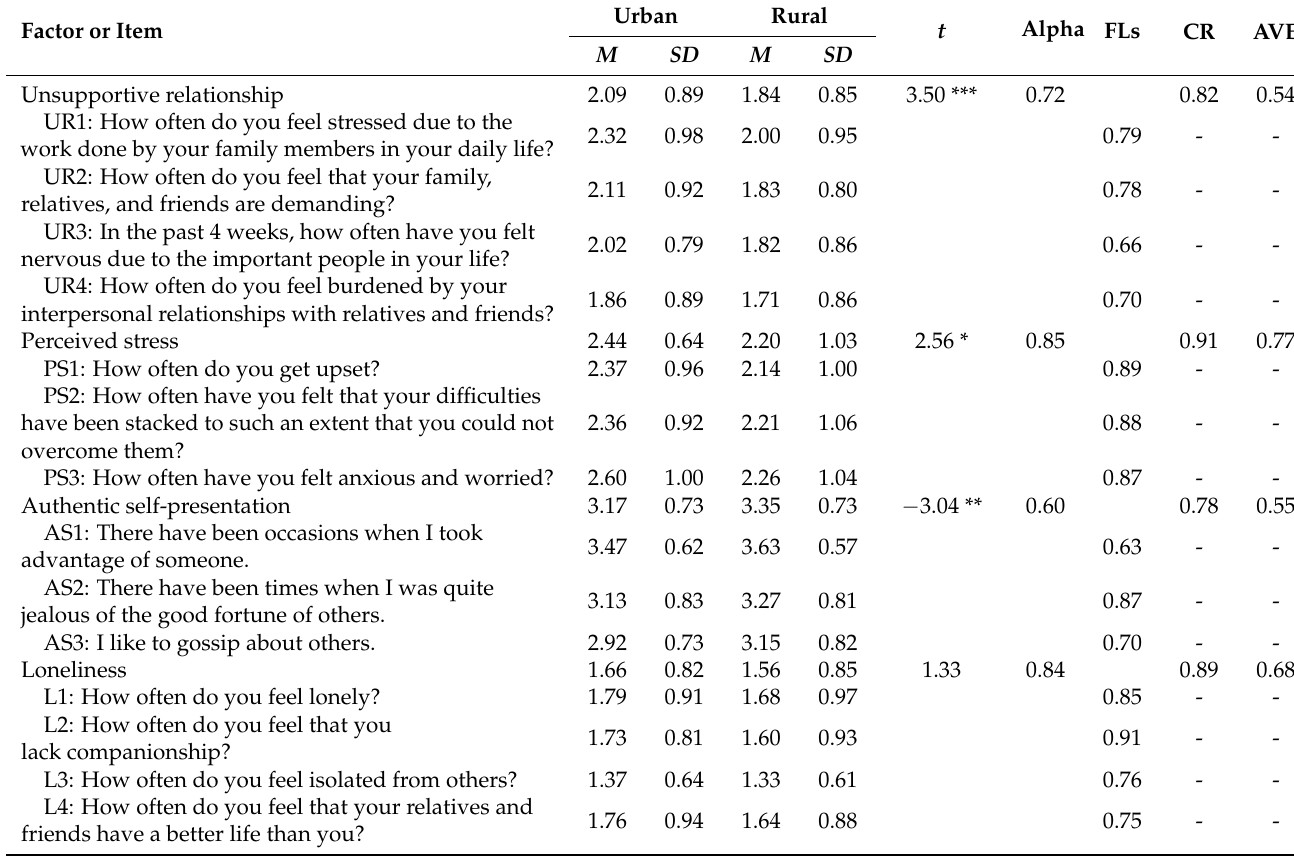
Table 2. Descriptive analysis and confirmatory factor analysis results ( n = 356).